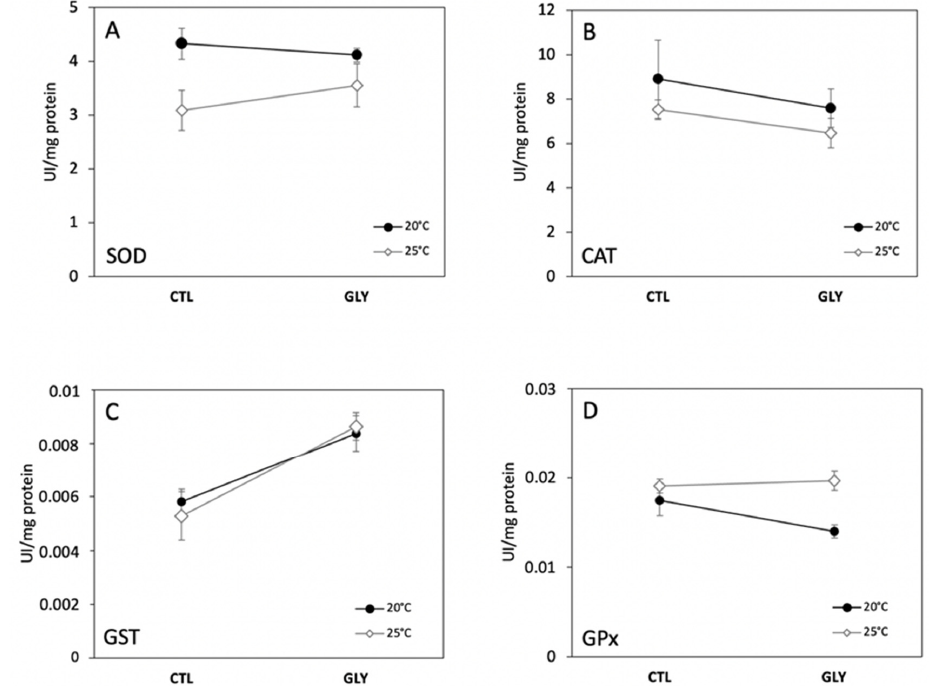
Figure 2. Antioxidant enzymes activities in snails ( Lymneae sp.) (SOD ( A ), CAT ( B ), GST ( C ) and GPx ( D )) among different exposure conditions at 20 and 25 °C (CTL: control group and GLY: glyphosate exposed group). Values are expressed as mean ± SEM (n = 6 for GST and GPx and n = 5 for SOD and CAT). Table 1. Results from the fixed effect two-way analyses of variance (ANOVAs) with * p < 0.1; ** p < 0.05; *** p < 0.005. Glyphosate (GLY), temperature (TEMP), glyphosate*temperature